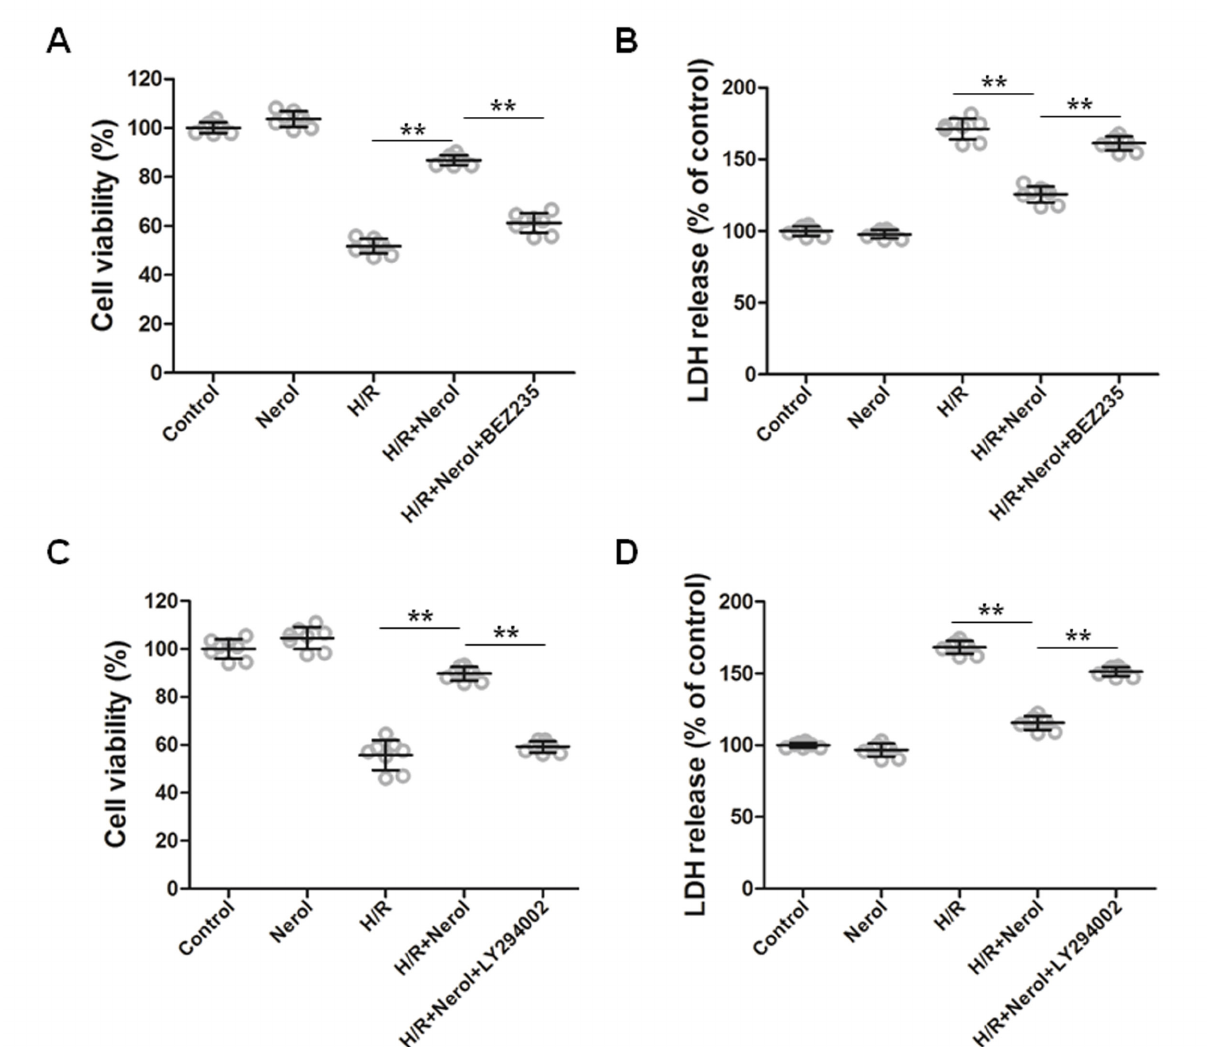
Figure 5. The effects of Nerol were abolished by the addition of PI3K inhibitors in cardiomyocytes. (A & B) H9c2 cardiomyocytes were treated with 5 μM Nerol in the presence or absence of 5 μM BEZ235, followed by H/R treatment for 12/12 h, or H9c2 cardiomyocytes were only treated with 5 μM Nerol for 24 h. Then, cell viability was evaluated by CCK-8 assay (A), and LDH release was estimated by LDH release assay (B). (C & D) H9c2 cardiomyocytes were treated with 5 μM Nerol in the presence or absence of 5 μM LY294002, followed by H/R treatment for 12/12 h, or H9c2 cardiomyocytes were only treated with 5 μM Nerol for 24 h. Then, cell viability was evaluated by CCK-8 assay (C), and LDH release was estimated by LDH release assay (D). n=8. p<0.01